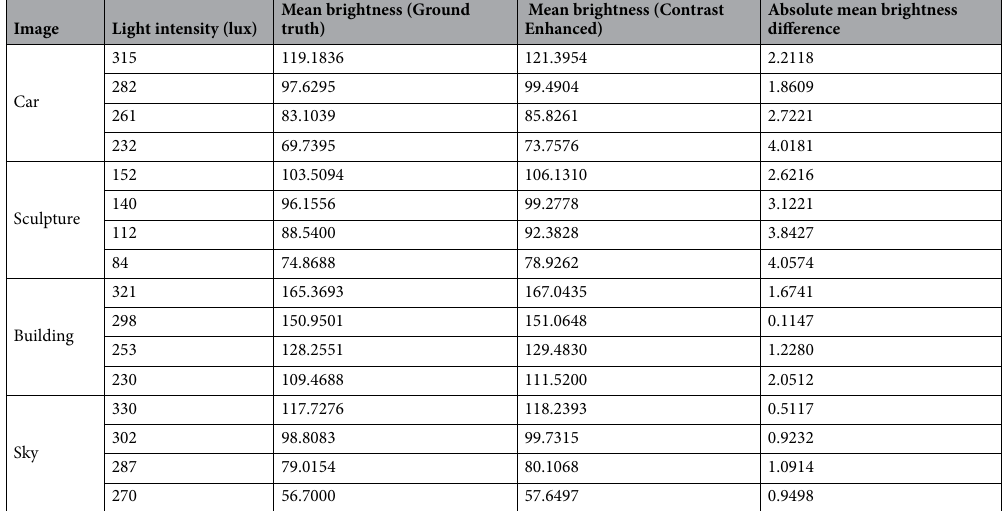
Table 3. Mean Brightness and Absolute Mean Brightness Difference.